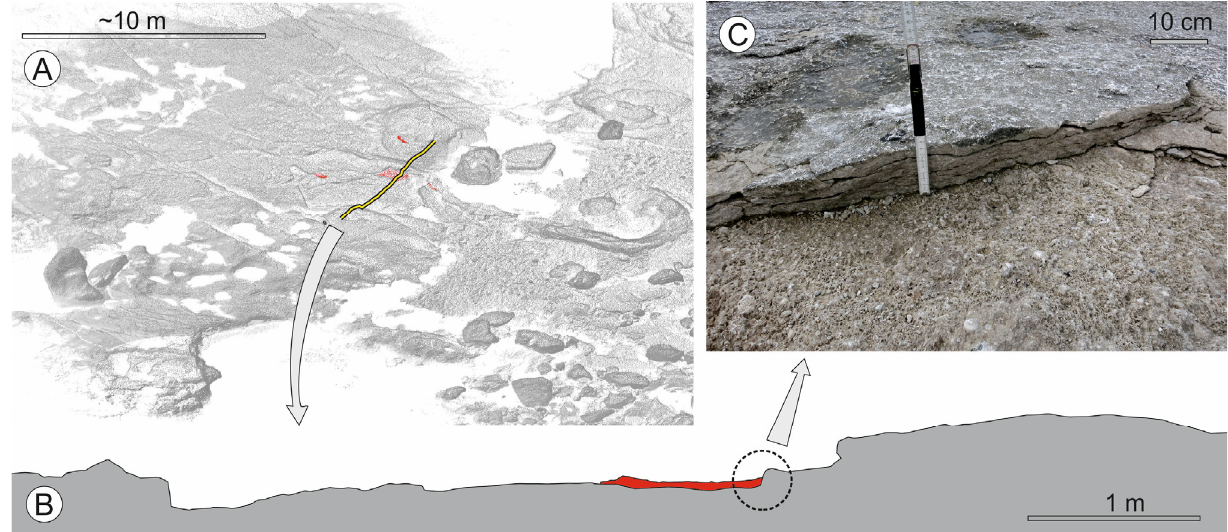
Figure 8. Examples of limestone slabs erosion: ( A ) point cloud with a profile line (marked in yellow) and points of erosion (marked in red); ( B ) terrain profile based on point clouds with a marked point of limestone plate dislodging; ( C ) a piece of rock identified in the field showing traces of recent dislodging.